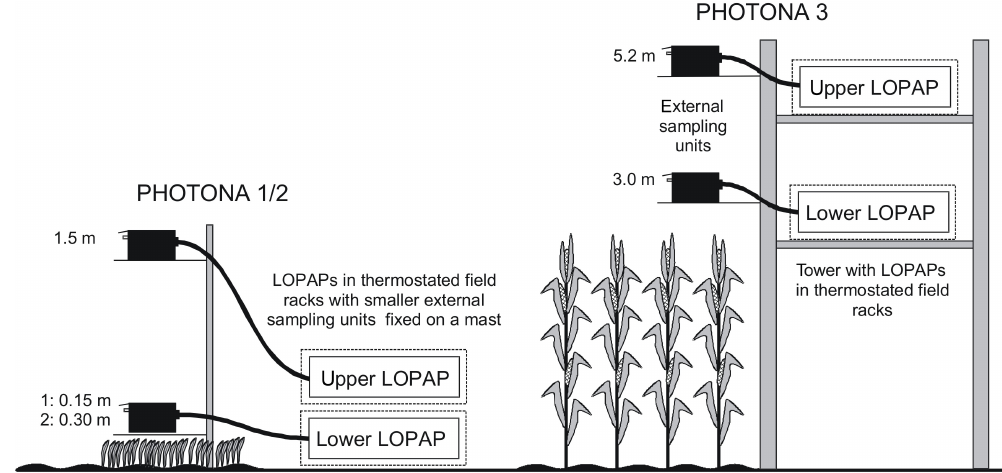
Figure 1. HONO aerodynamic gradient set-up during the PHOTONA campaigns. Left: PHOTONA 1 (bare soil) and 2 (triticale canopy) with the two external sample units fixed on a mast. Right: scaffold tower during PHOTONA 3 (maize canopy) with the LOPAPs placed at different levels on the